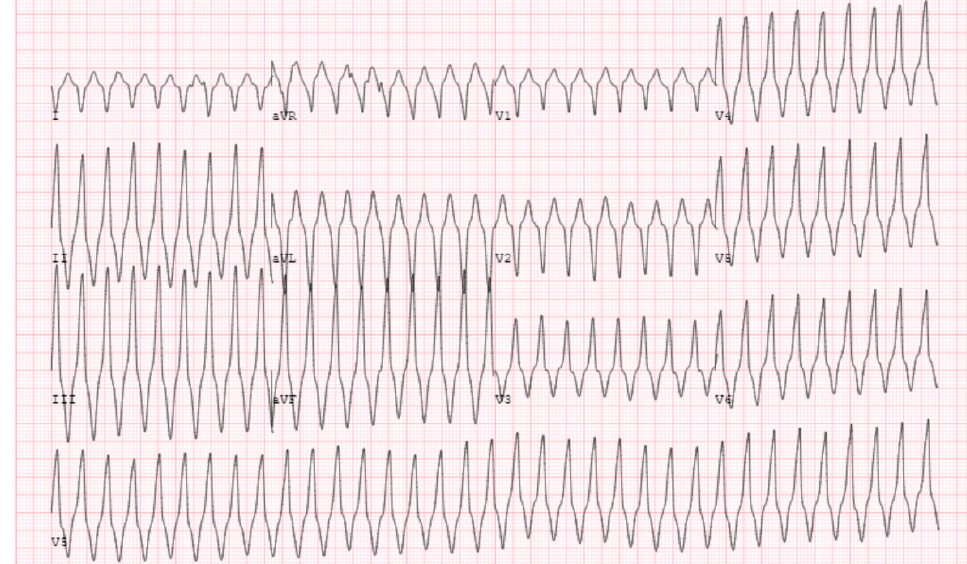
Figure 5. ECG from LVOT showing a rightward inferior axis with early transition at V3. Successful ablation was performed at LSoV. This also required ablation at the AMC region .